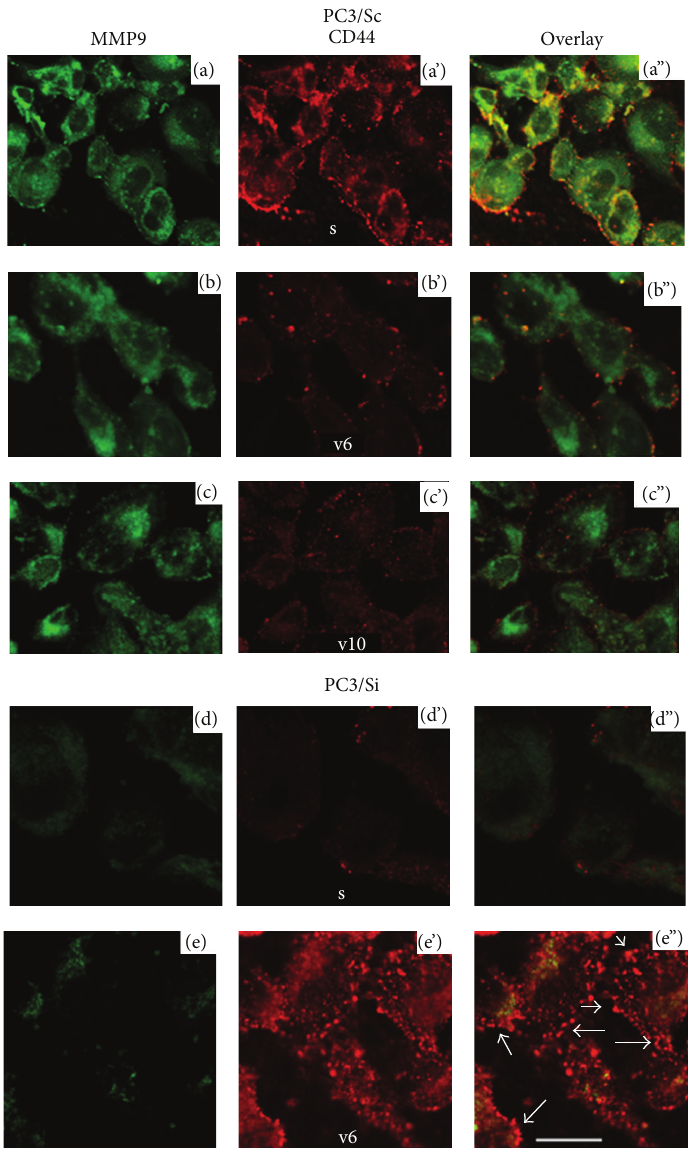
Figure 3: Immunostaining and confocal microscopy analysis of surface distribution of MMP9 and indicated CD44 isoforms in PC3/Sc and PC3/Si cell lines. Immunostaining was performed with antibodies to MMP9 (green) and isoforms of CD44 (s, v6, and v10; red). Distribution of both MMP9 and indicated CD44 isoforms is shown in overlay panels (a”)–(e”). Yellow color indicates colocalization of CD44s and MMP9 on the cell surface (overlay panel a”). Scale bar-50 𝜇 m. The results represent one of three experiments performed.